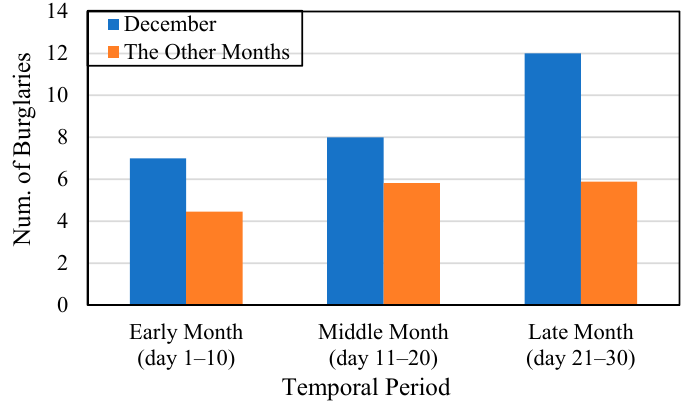
Figure 12. The intra-month variations of burglary in December and the other months in 2010.